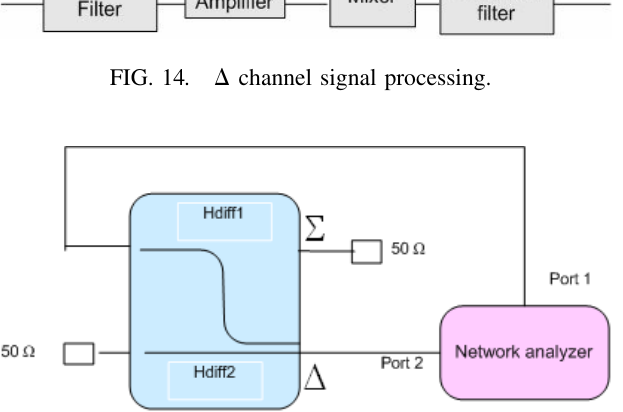
FIG. 15. (Color) S parameters measurement of the hybrid 180 (cid:9) .